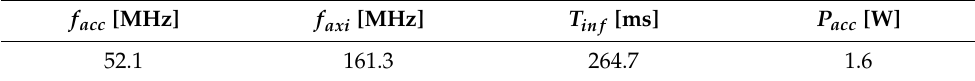
Table 5. Results summary for XQRKU060 accelerator implementation.